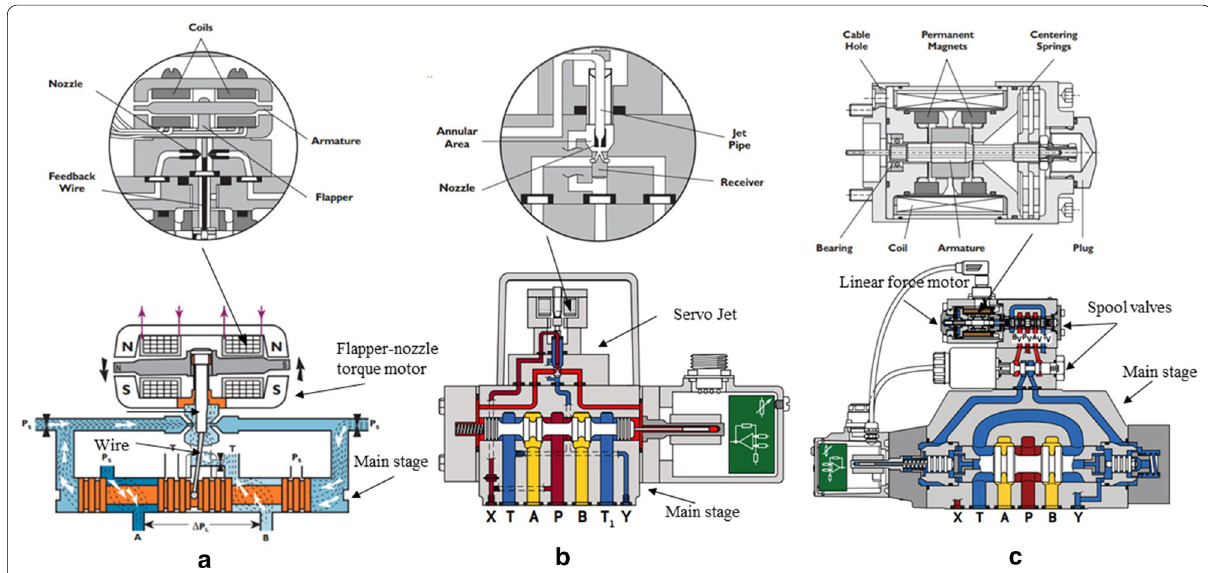
Figure 6 Multi-stage valves and pilot stages’ actuators: ( a ) Flapper-nozzle pilot stage; ( b ) Servo jet pilot stage; ( c ) Spool valve pilot